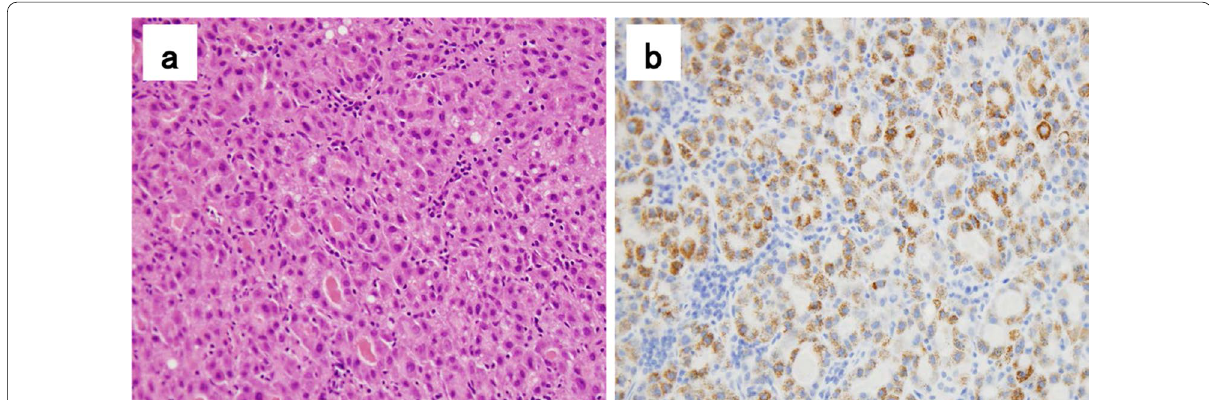
Fig. 2 Histological finding on hematoxylin–eosin staining and immunohistochemistry. a Cervical lymph node metastasis. b Hepatocyte positivity in tumor cells